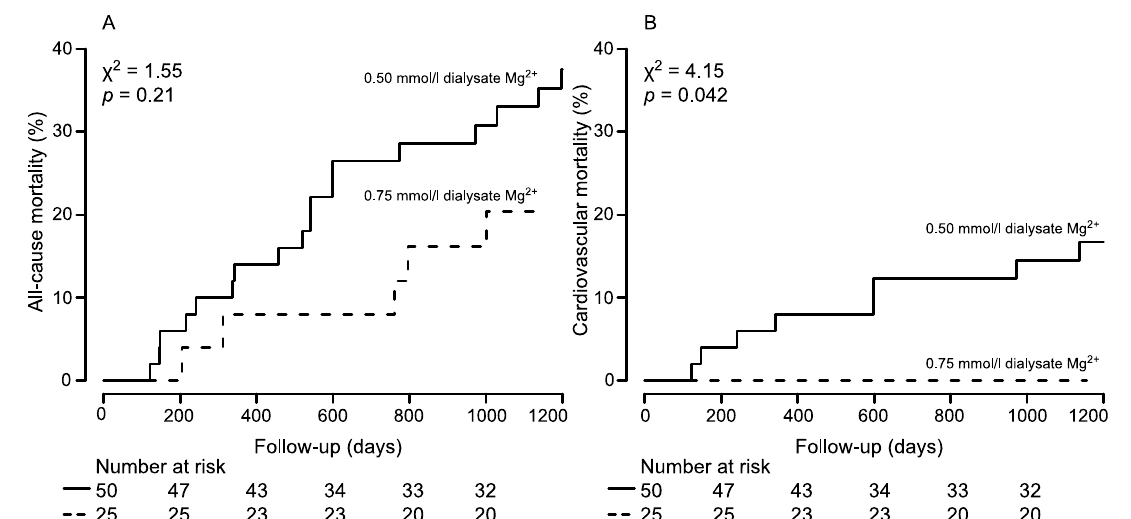
Figure 2. Cumulative all-cause mortality ( A ) and cardiovascular mortality ( B ) curves for patients stratified by low (0.50 mmol/L) and high (0.75 mmol/L) dialysate magnesium concentration, respectively. The number of patients of the individual groups involved in the analysis at 0, 200, 400, 600, 800, and 1000 days are shown below each